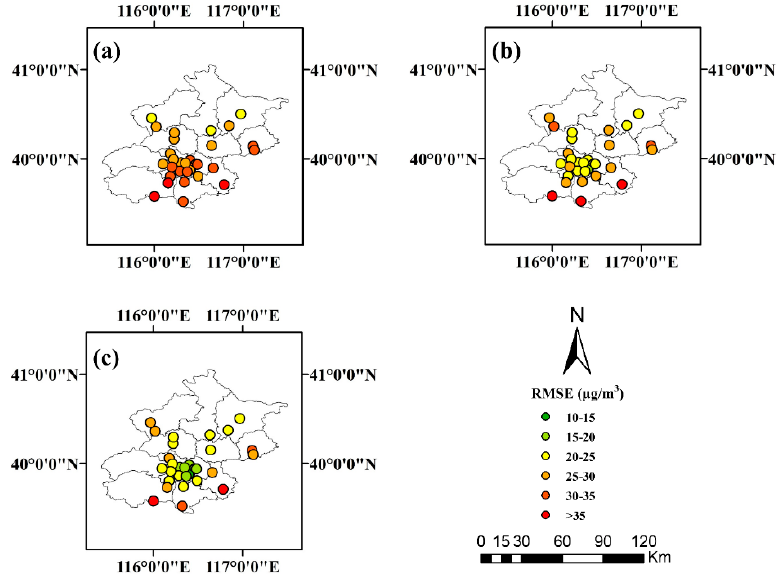
Figure 4. The density scattering plots of CV results. Sample-based result: ( a ) GWR, ( b ) XGBoost and ( c ) SL-XGB. Site-based result: ( d ) GWR, ( e ) XGBoost and ( f ) SL-XGB. The red lines represent the 1:1 lines and the black lines represent the fitting lines.